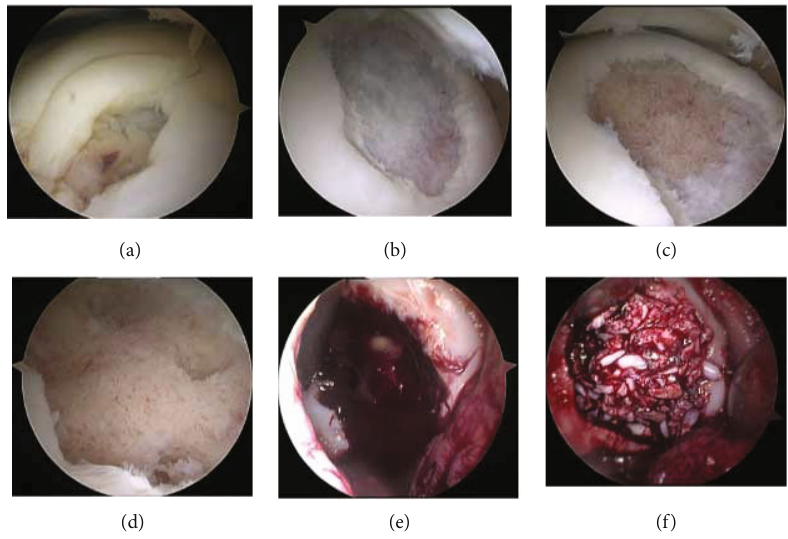
Figure 2: Surgical treatment of an osteochondral lesion by autologous bone grafting and minced cartilage. (a) Osteochondral lesion with (b) subsequent cartilage removal by (c) debridement with a curette and (d) removal of the subchondral cysts. (e) View of the defect after miniarthrotomy and (f) after autologous cancellous bone grafting and application of the minced